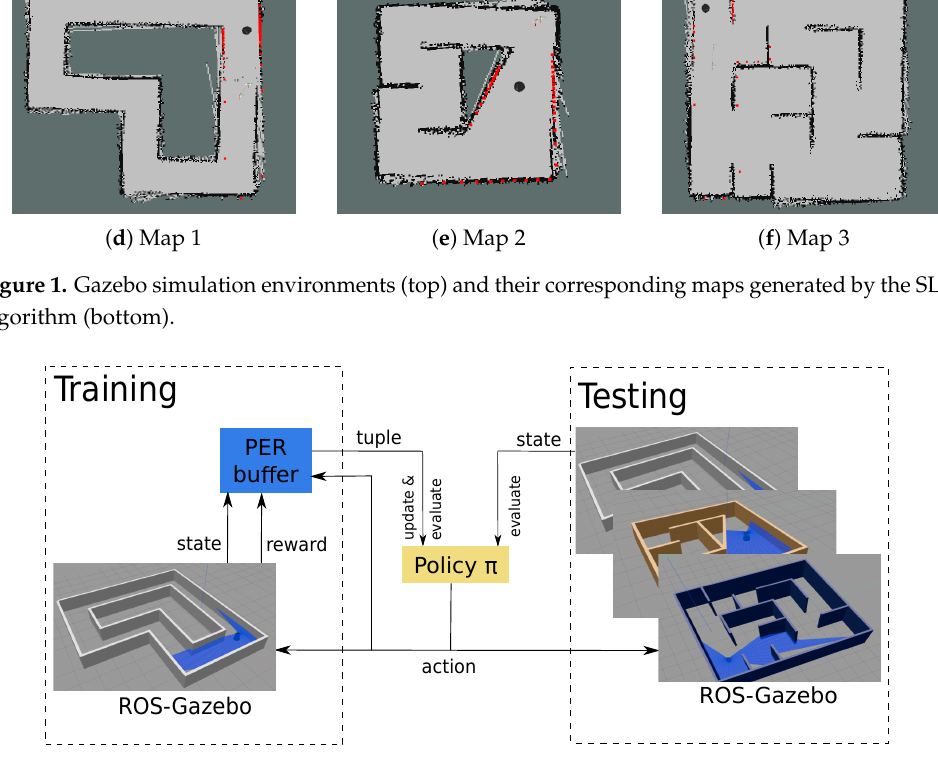
Figure 2. Training ( left ) and testing ( right )